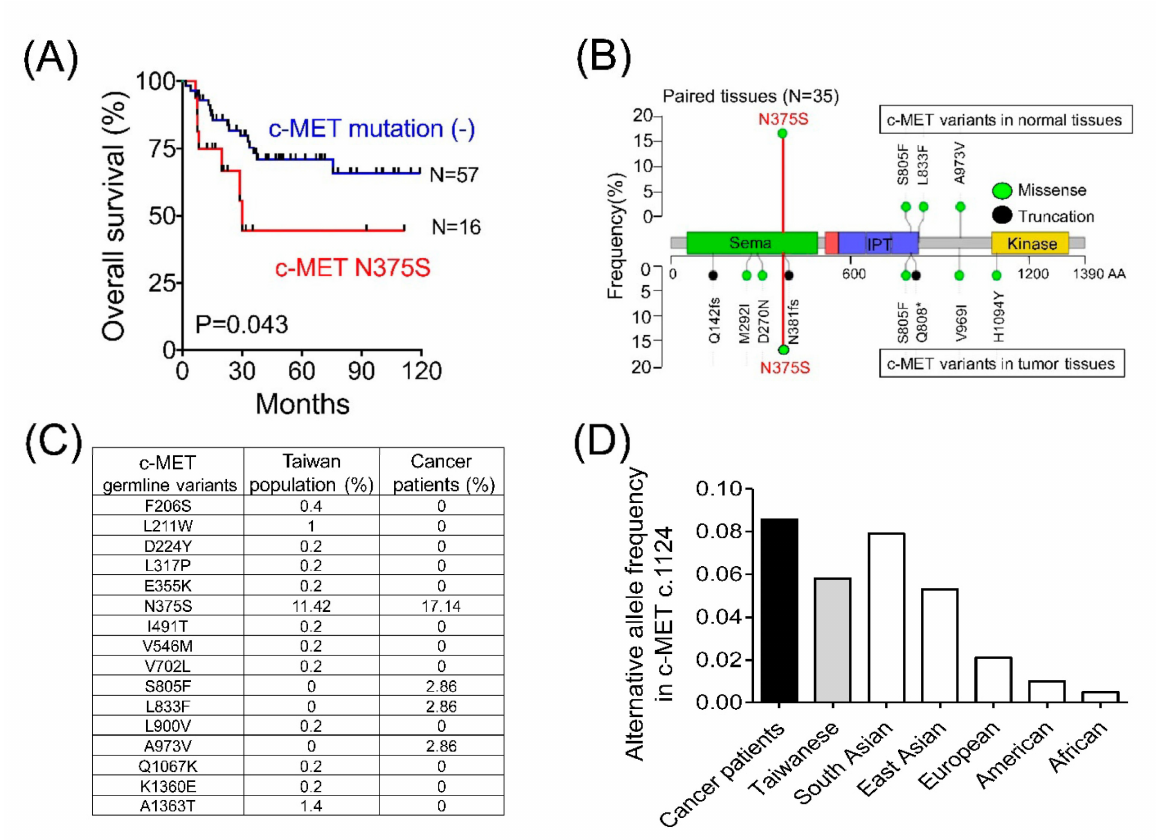
Figure 4. The clinical impact, distribution, and frequency of the germline MET N375S variant. ( A ) OS of advanced endometrial cancer patients with and without the MET N375S variant. ( B ) The distribution and frequency of MET variants in 35 paired normal and tumor tissues. Whole-genome sequencing was used to analyze DNA extracted from blood samples or adjacent non-tumor specimens to determine germline MET variants. ( C ) The distribution and frequency of germline MET variants in cancer patients and the normal Taiwan population. The database from the Taiwan Biobank, which contained germline whole-genome sequencing data of 499 normal Taiwanese individuals, was used to compare the distribution and frequency of germline MET variants in the NCKUH cohort and the normal Taiwan population. ( D ) The alternative allele frequency of MET c.1124 (N375S) in the different ethnic groups. The frequency of the variant allele in MET c.1124 was compared among the NCKUH cohort, the normal Taiwanese population, and different ethnic groups enrolled in the 1000 Genomes